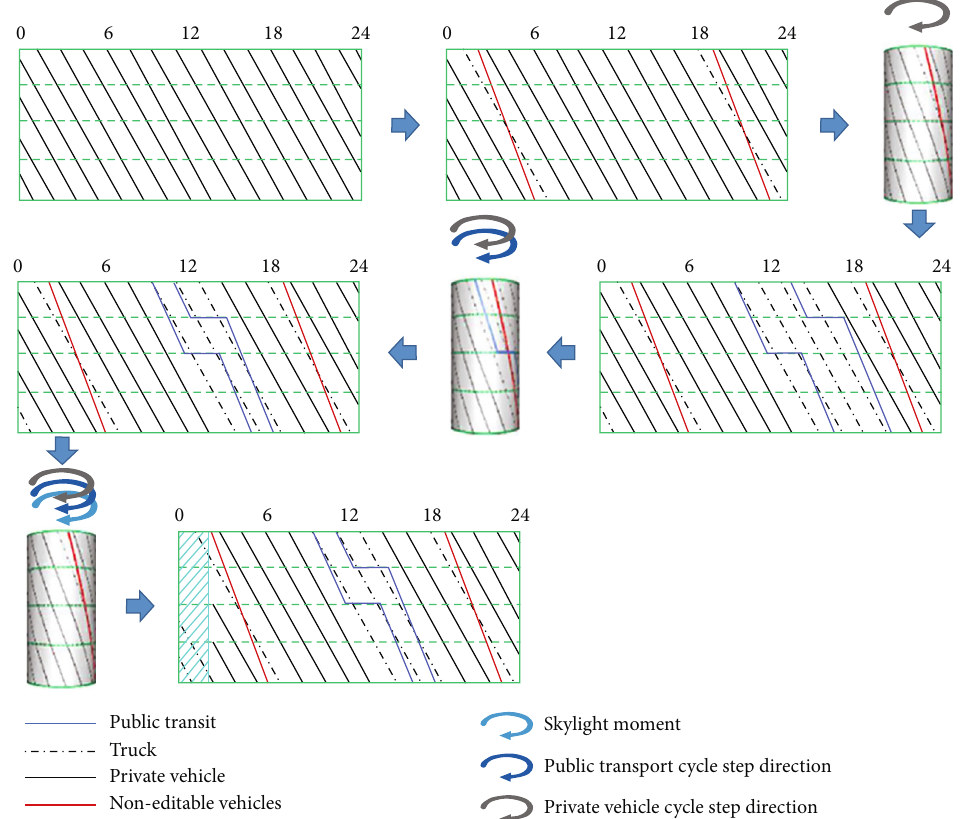
Figure 7: Calculation of vehicle passing ability data map of regional road sections based on improved mathematical